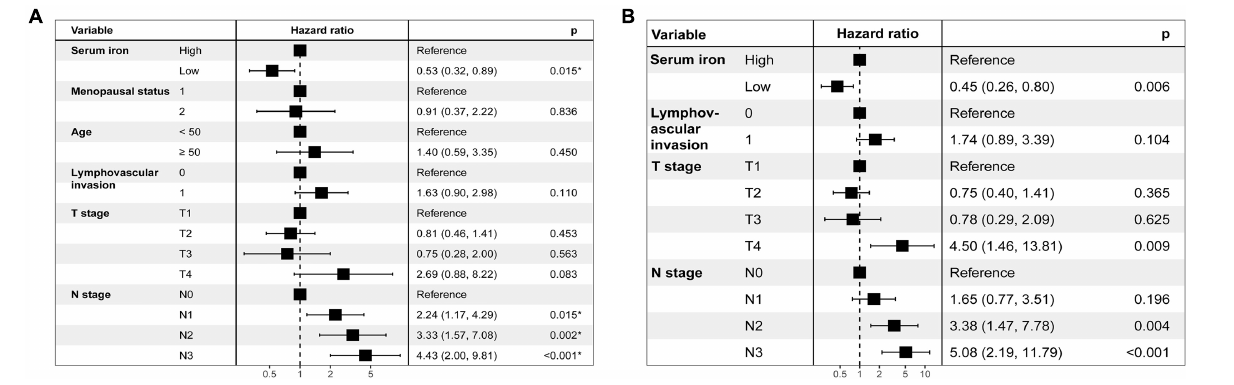
Frontiers in Cell and Developmental Biology |